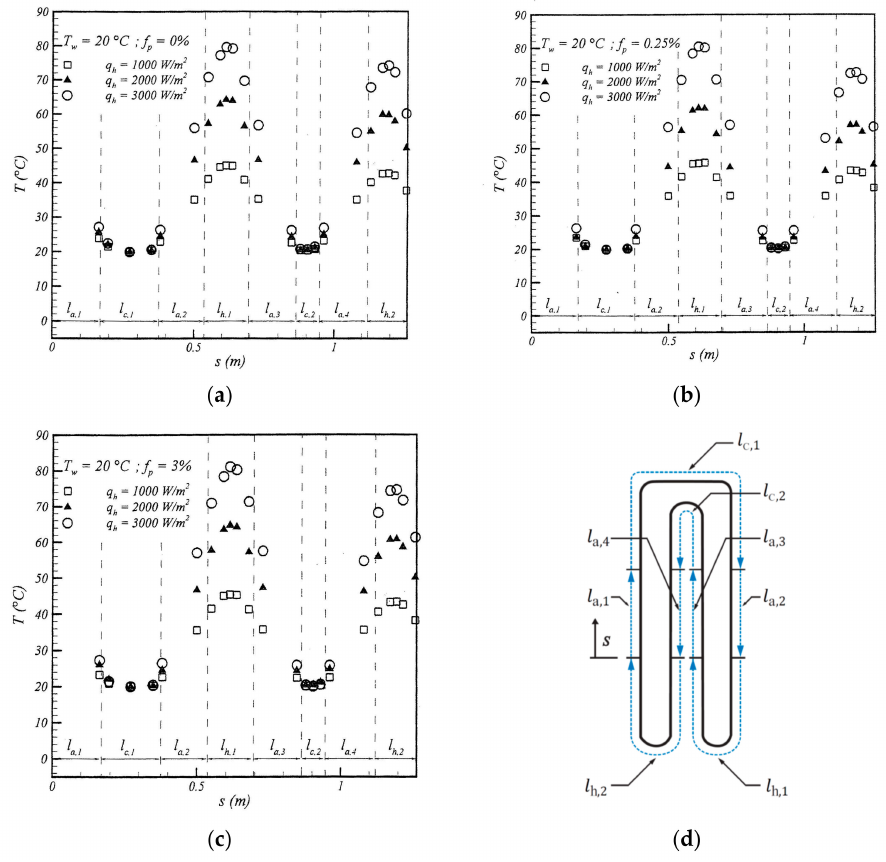
Figure 8. Steady-state temperature distributions of the fluid under different q h value ( T w = 20 ◦ C): ( a ) f p = 0%; ( b ) f p = 0.25%; ( c ) f p = 3%; ( d ) The experimental